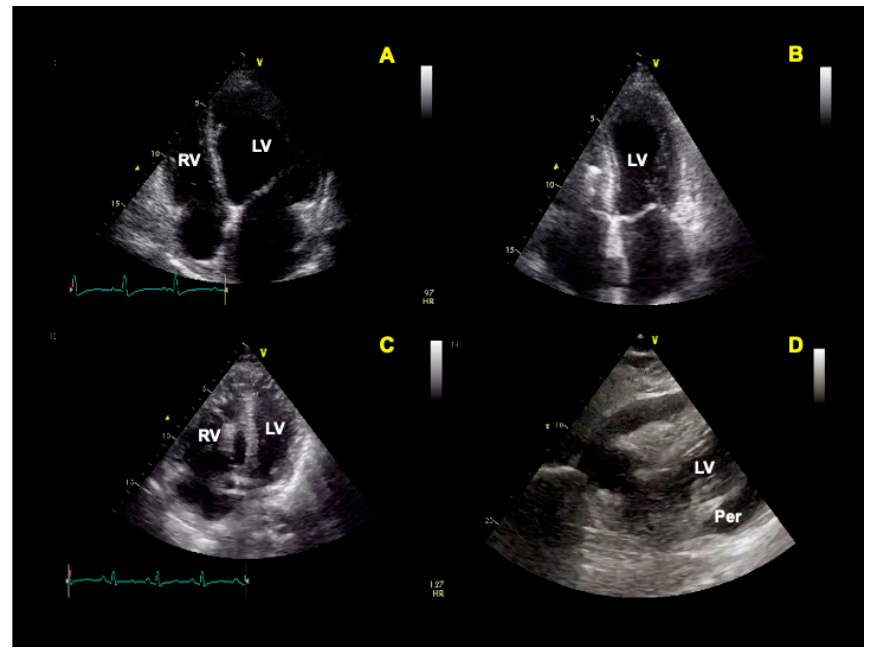
Figure 2. Possible features of echocardiography in COVID patients. ( A ) Left ventricle (LV) dilatation and dysfunction; ( B ) Takotsubo cardiomyopathy; ( C ) right ventricle (RV) dilatation secondary to pulmonary embolism; ( D ) pericardial (Per) effusion.